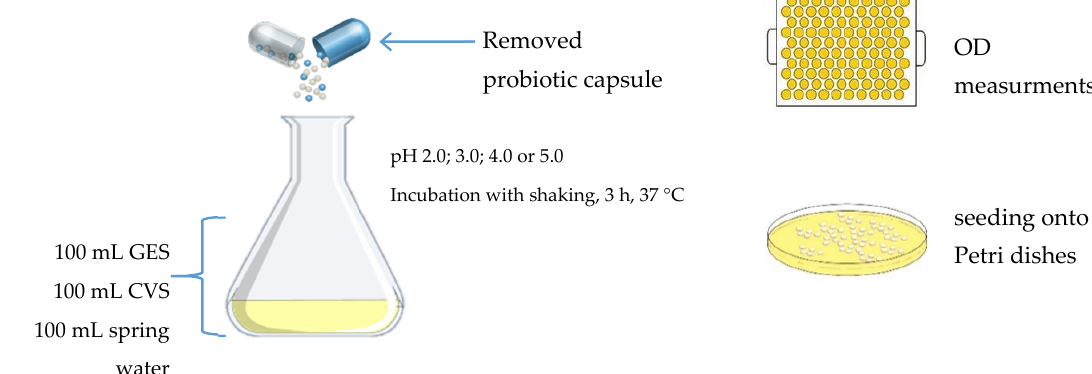
Figure 1. Scheme of the variants tested under gastric stage of experiment (GES—gastric electrolyte solution, CVS—chicken–vegetable soup).